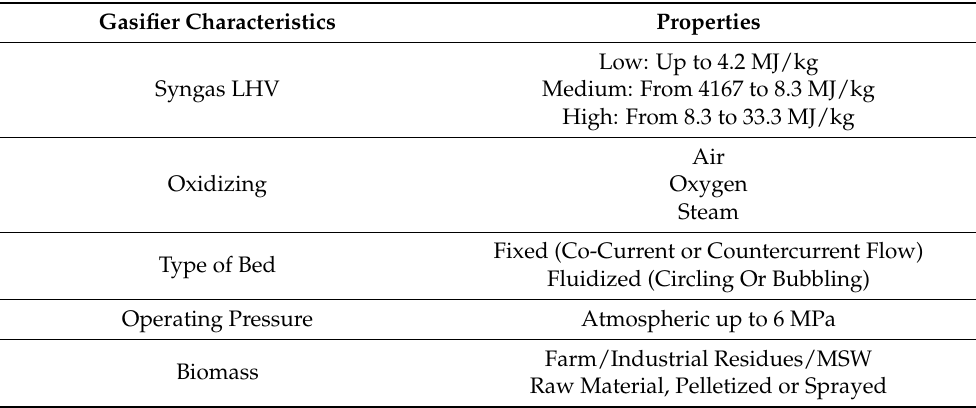
Table 2. Gasifier characteristics (FEAM, 2010 apud [12], p.